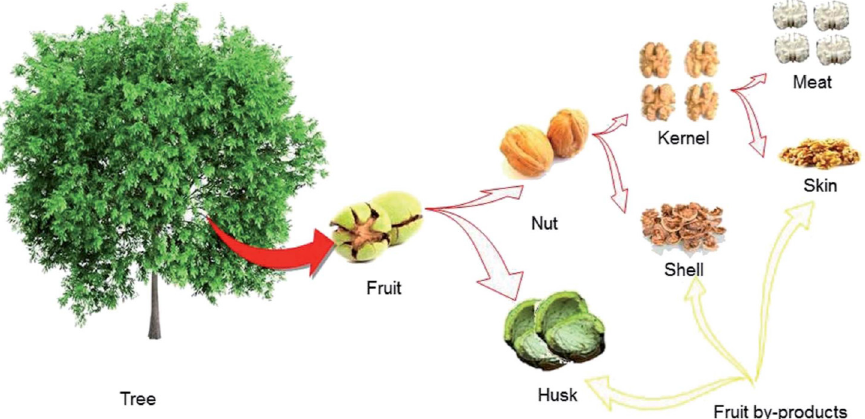
Figure 8. Different parts of walnut fruit and the corresponding by-products. The walnut fruit mainly consists of the husk, shell, skin, and kernel. The husk, shell and skin are the main agricultural waste products of walnut fruit. Reprinted from [17].